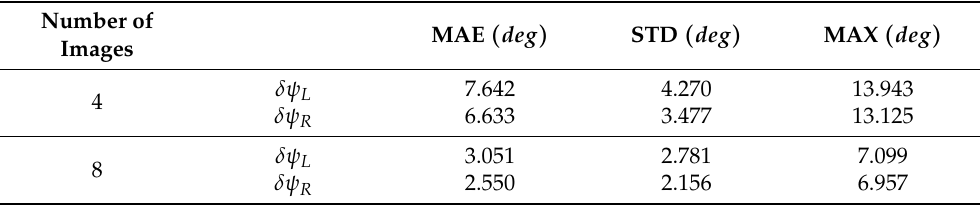
Table 3. Statistical results of yaw-angle bias